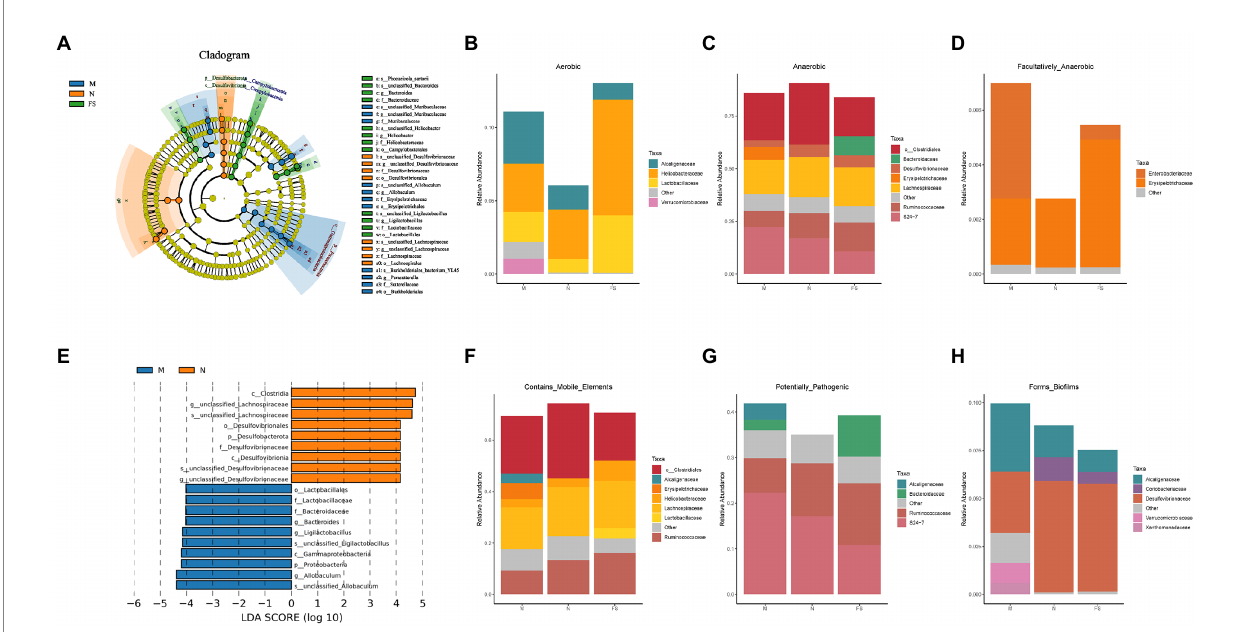
FIGURE 7 Postbiotic of hawthorn-probiotic decreases the abundance of intestinal or potential pathogens and increased the abundance of probiotics. (A) LEfSe analysis, the circles radiating from the inside out represent the classification levels from phylum to species; each small circle at a different classification level represents a classification at that level, and the diameter of the small circle is proportional to the relative abundance. The coloring principle is to color the species with no significant difference uniformly yellow, and color the other different species according to the group with the highest abundance. Different colors represent different groups, and different colored nodes represent the microbiome that plays an important role in the group represented by the color; (B) bar diagram of aerobic flora abundance at Family level in 3 groups; (C) bar diagram of the abundance of anaerobes at the Family level in 3 groups; (D) bar diagram of the abundance of facultative anaerobes at the Family level in 3 groups; (E) LDA analysis, the ordinate represents the classification units with significant differences between groups, and the abscess represents the logarithm score of LDA analysis of each classification unit in a bar graph. The classification unit is sorted according to the score value. The longer the length, the more significant the difference of the classification unit. The color of the bar graph indicates the sample group corresponding to the higher abundance of the classification unit; (F) bar diagram of the abundance of facultative contains mobile elements at the Family level in 3 groups; (G) bar diagram of the abundance of facultative potential pathogenic bacteria at the Family level in 3 groups; (H) bar diagram of the abundance of facultative bacteria who form biofilm at the Family level in 3 groups.